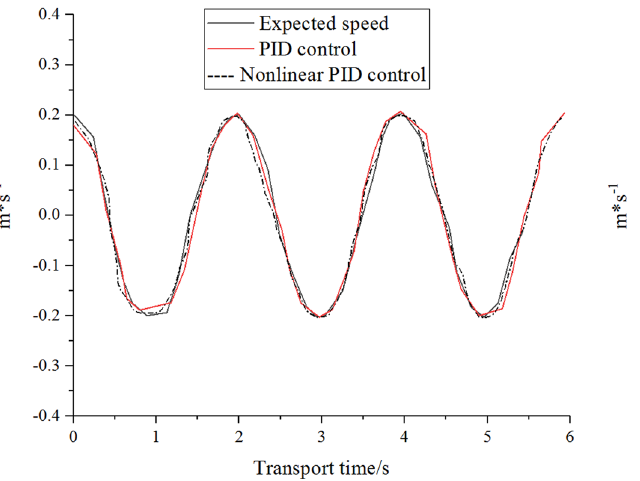
Figure 3: Piston speed response curve ( with load interference )